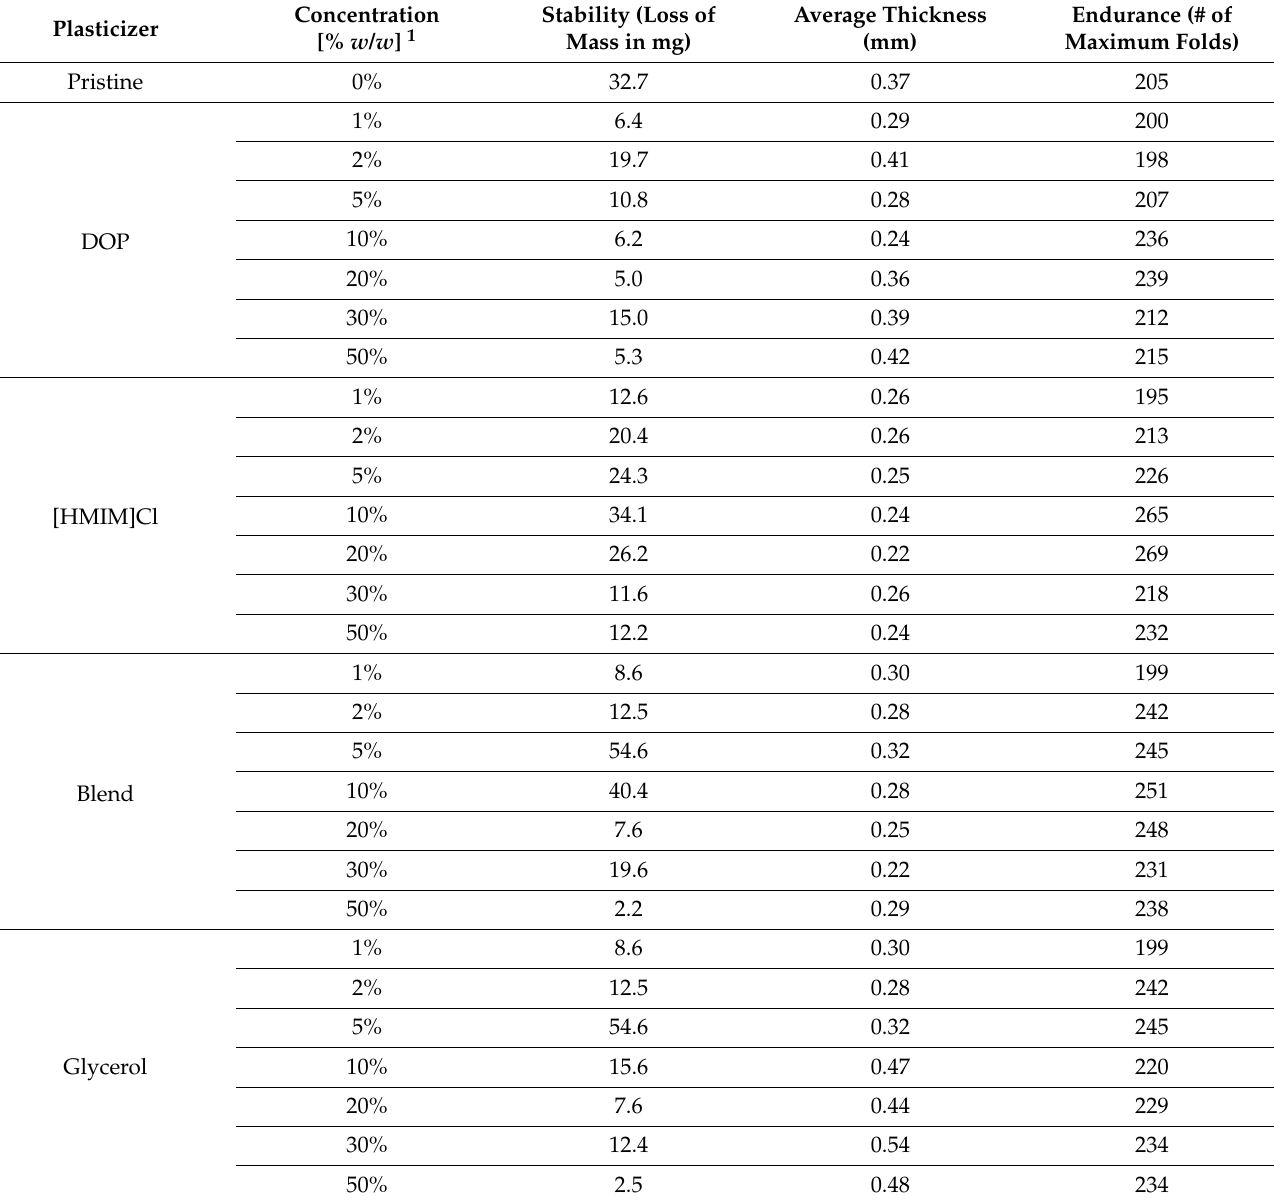
Table 2. Summary of physical tests is outlined in the table below, including total mass lost from samples over the testing period, thickness, and endurance